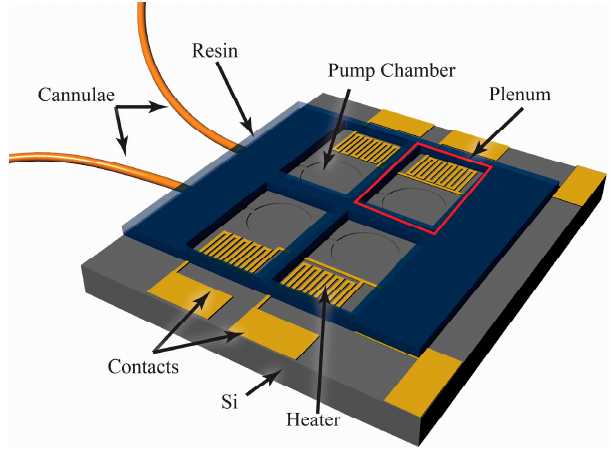
Figure 2. Conceptual illustration of a four-chamber peristaltic pump (6.4 mm × 4.4 mm × 1 mm) for